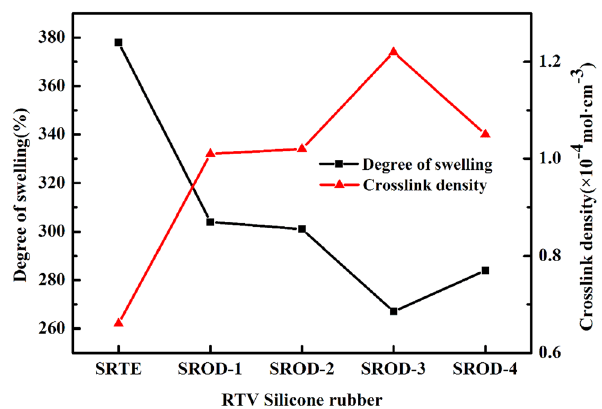
Figure 3: Degree of swelling and cross - linking density of RTV sili - cone